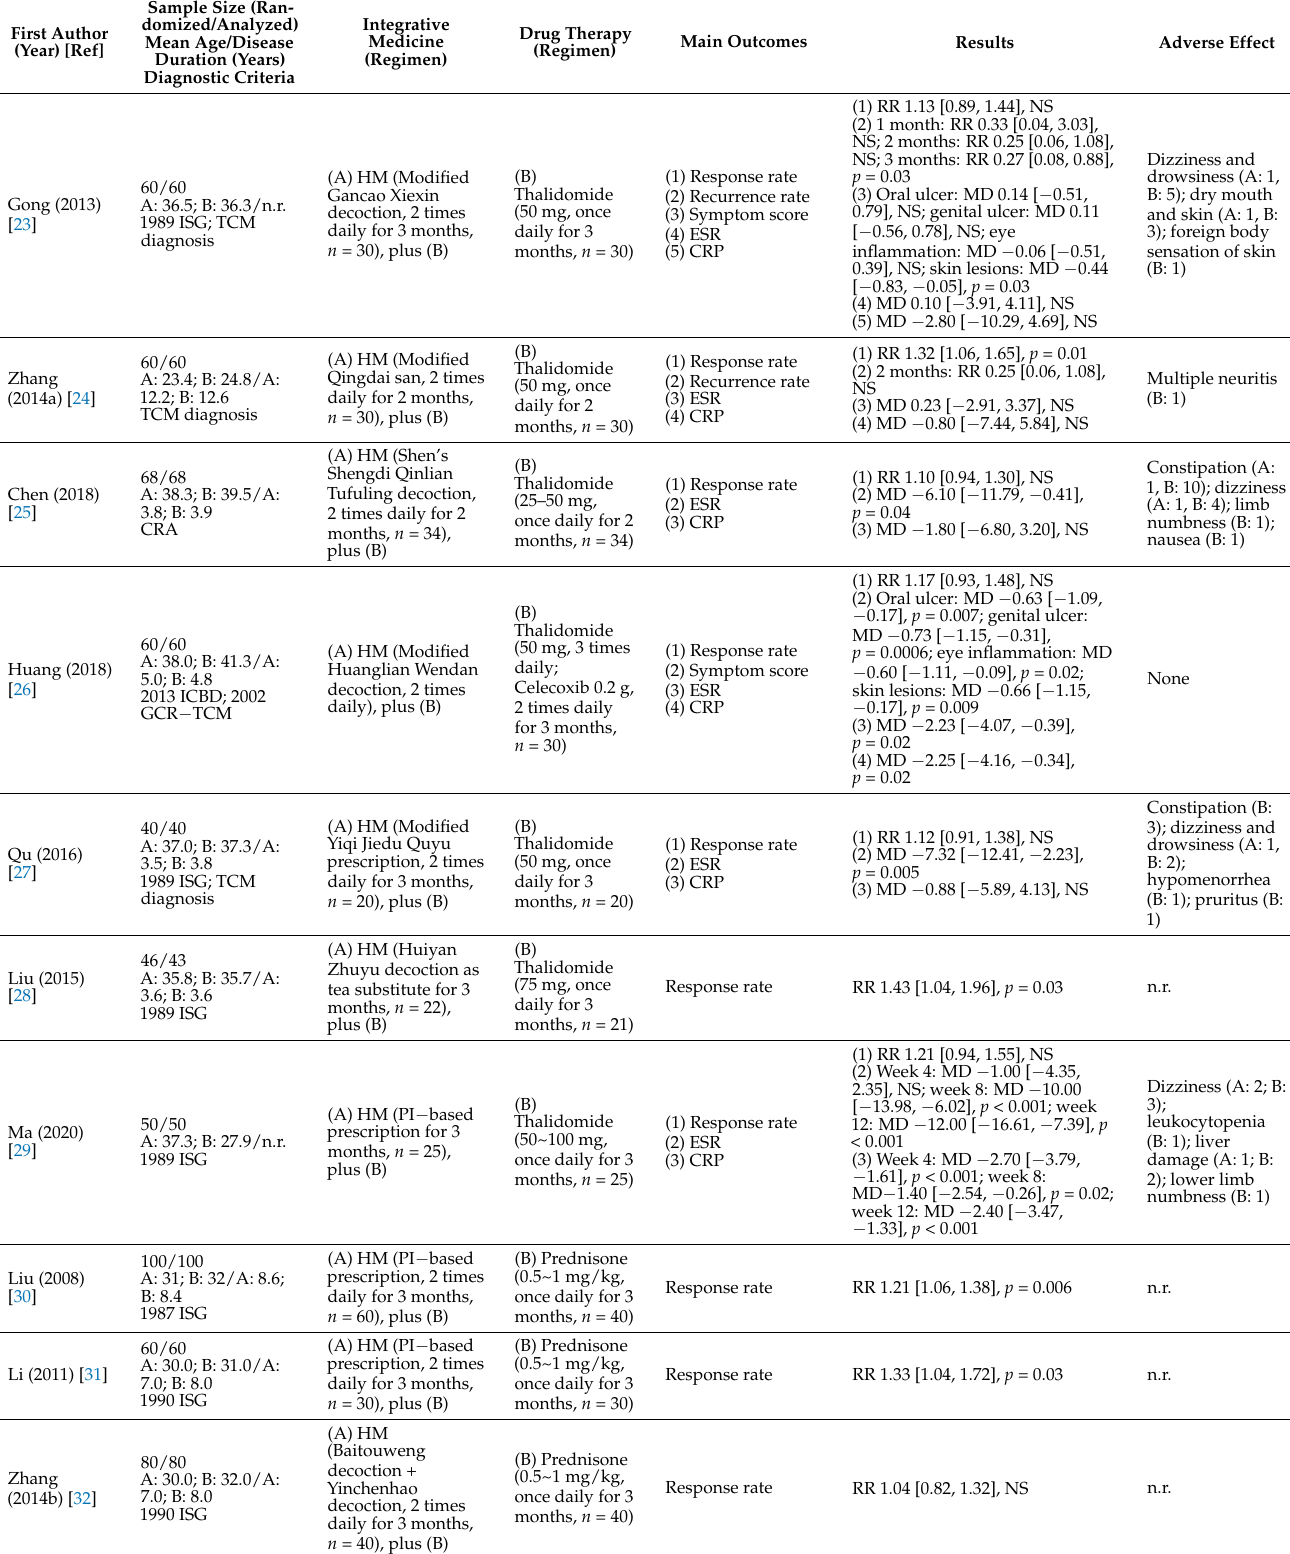
Table 1. Summary of randomized controlled trials on herbal medicine for the treatment of Behcet’s